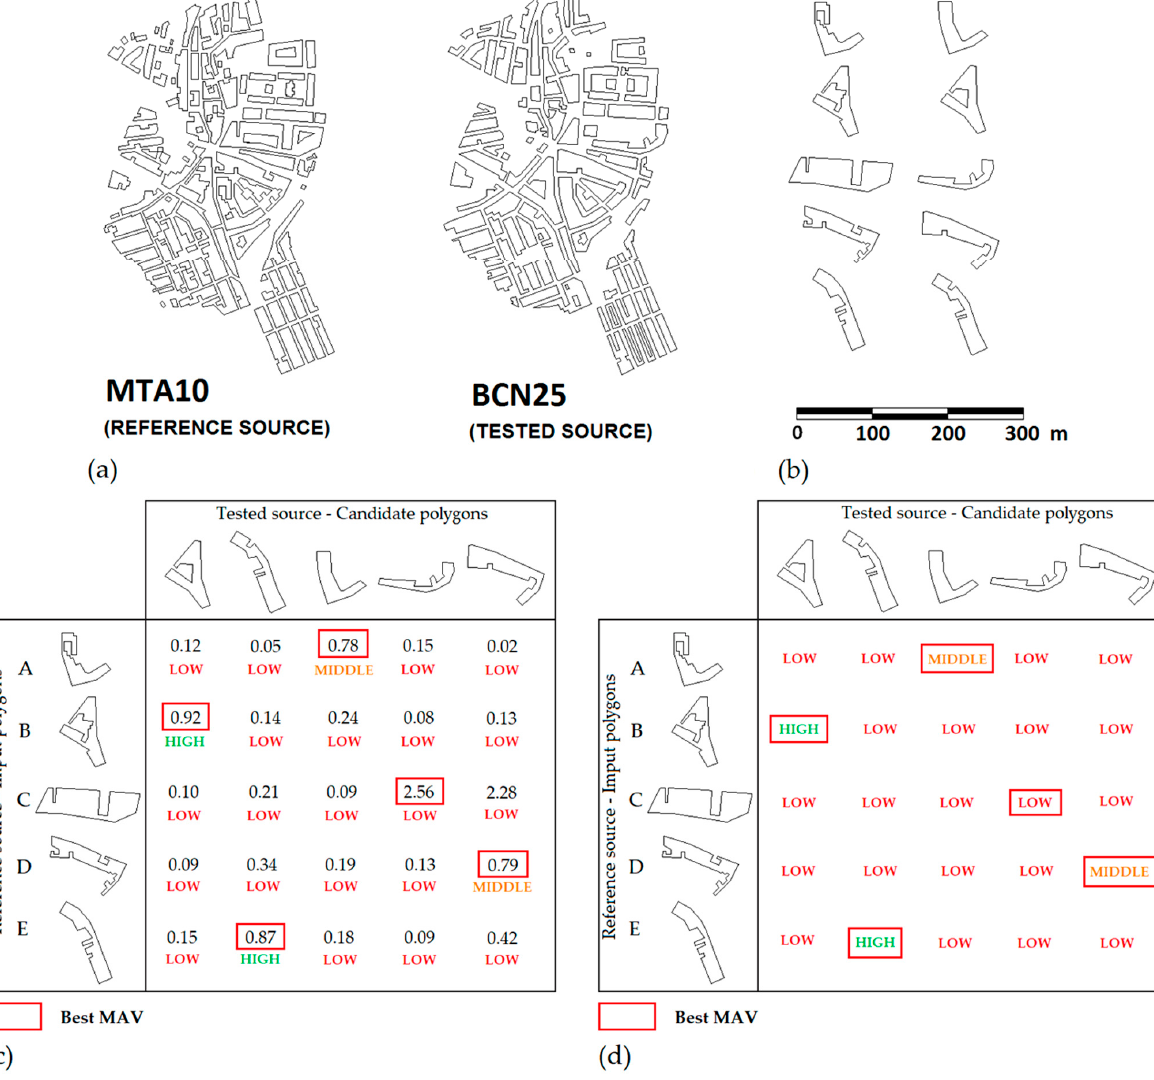
Figure 9. ( a ) One of nine urban areas employed in this study; ( b ) polygons belonging to this urban area and selected for the MAV experiment; ( c ) MAV computed by the GA; ( d ) discretized MAV assigned by a specific